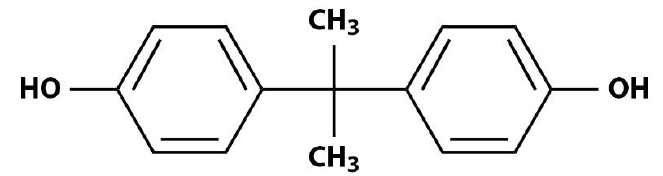
Figure 1. Chemical structure of bisphenol A.